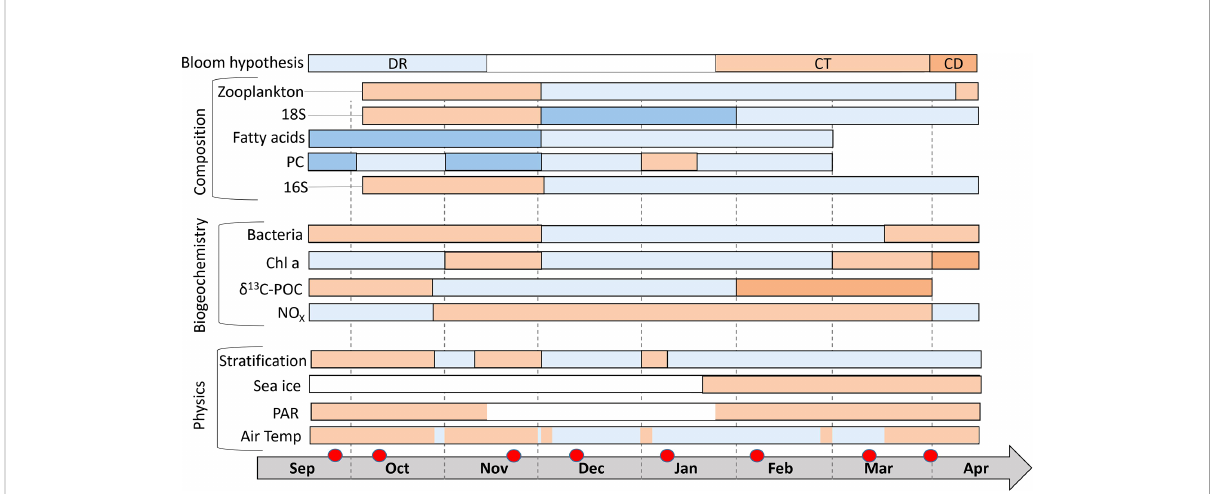
FIGURE 10 Schematic summary linking selected physical and biogeochemical variables and clustering (composition) of the 16S and 18S communities and Metabolomics data. Air temperatures >0°C are marked in orange and below 0°C in blue. Irradiance (as PAR) is marked in orange if the average daily intensity was >0.5 µE m -2 s -2 . Sea ice presence at st 1 is marked in orange. Suggested existence of a strati fi ed water column is marked in orange. NO X concentrations > 4 µmol L -1 and d 13 C-POC ratios >-29 ‰ and bacteria abundances above 2 10 5 cells ml -1 are marked in orange. Chl concentrations >0.5 mg m -3 are marked in orange and Chl values > 5 mg m -3 in dark orange. The composition patterns are indicated based on the NMDS clusters using two to three different colors for the different clusters/compositions. Typical monthly zooplankton biovolumes (Coguiec et al., 2021) above 1 g dw m -3 are marked in orange and lower values in blue. Red circles indicate the sampling times. Dashed black lines separate months. The bloom hypothesis bar indicates which hypothesis is driving the phytoplankton dynamics leading to autumn and spring blooms (DR: Dilution-recoupling hypothesis, CT: Critical turbulence hypothesis, CD: Critical depth hypothesis, black: light